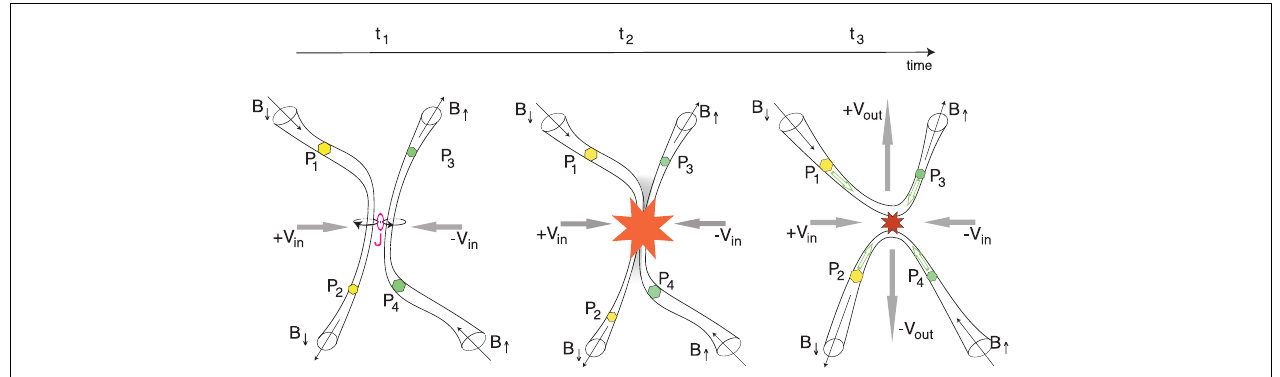
FIGURE 2 | Schematic of the interaction of two flux tubes of different radii leading to reconnection when approaching each other with inflow speed V in . The tubes carry magnetic fields B ↓ , B ↑ that, over a certain length along the flux tubes, are oppositely directed. When the tubes approach each other at time t 1 , a narrow current layer of length with current density J occurs between them. Once contacting at time t 2 , the antiparallel fluxes annihilate (as indicated symbolically by the red star). The excess magnetic energy is consumed